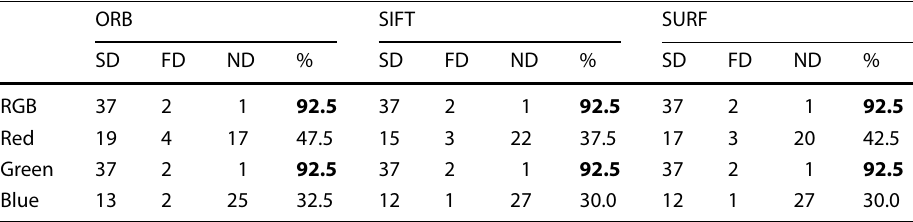
Table 1 Optic disc detection results on the DRIVE